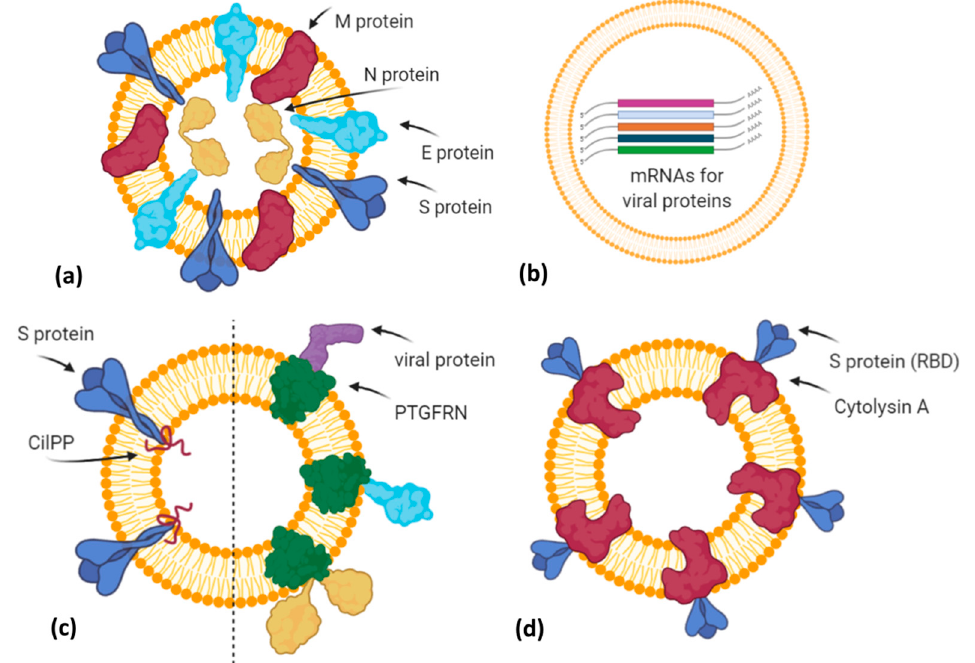
Figure 3. A simplified graphical representation of different EV-based vaccine strategies under development by various biotech companies. ( a ) Capricor Therapeutics transfected HEK293 cells with vectors for Spike, Nucleocapsid, Membrane, and Envelope SARS-CoV-2 proteins in order to release EVs (or virus-like particles) carrying viral antigens in their native conformation; ( b ) Carpicor Therapeutics formulated a COVID-19 vaccine by loading into EVs mRNAs for full-length S protein and for modified S, N, M, and E proteins inserted within Lamp1 protein for a better presentation on MHC I and II molecules. Allele Biotechnology and Pharmaceuticals is also developing an EV-based mRNA vaccine, but details are not available; ( c ) CoVEVax vaccine by Ciloa company consists of EVs displaying full S protein, thanks to the EV-sorting peptide CilPP (left). Similarly, exoVACC™ vaccine of Codiak BioSciences consists of EVs engineered to display still-undeclared SARS-CoV-2 proteins, thanks to the scaffold protein PTGFRN (right); ( d ) bacterial Outer Membrane Vesicles (OMVs) engineered by Versatope Therapeutics for the display of Spike protein (receptor binding domain (RBD) portion) by fusing it with the OMV-anchoring protein cytolysin A (ClyA). Created with BioRender.com.